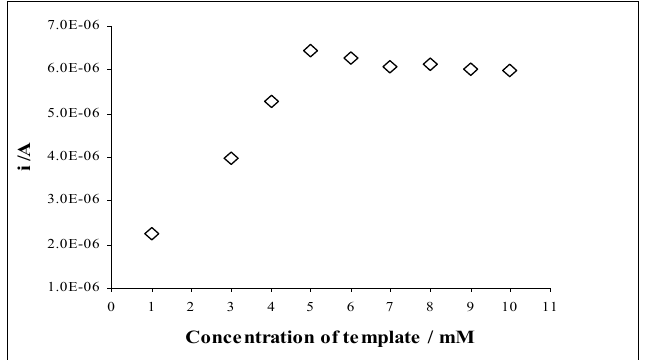
Figure 10. Effect of the template concentration to MIP